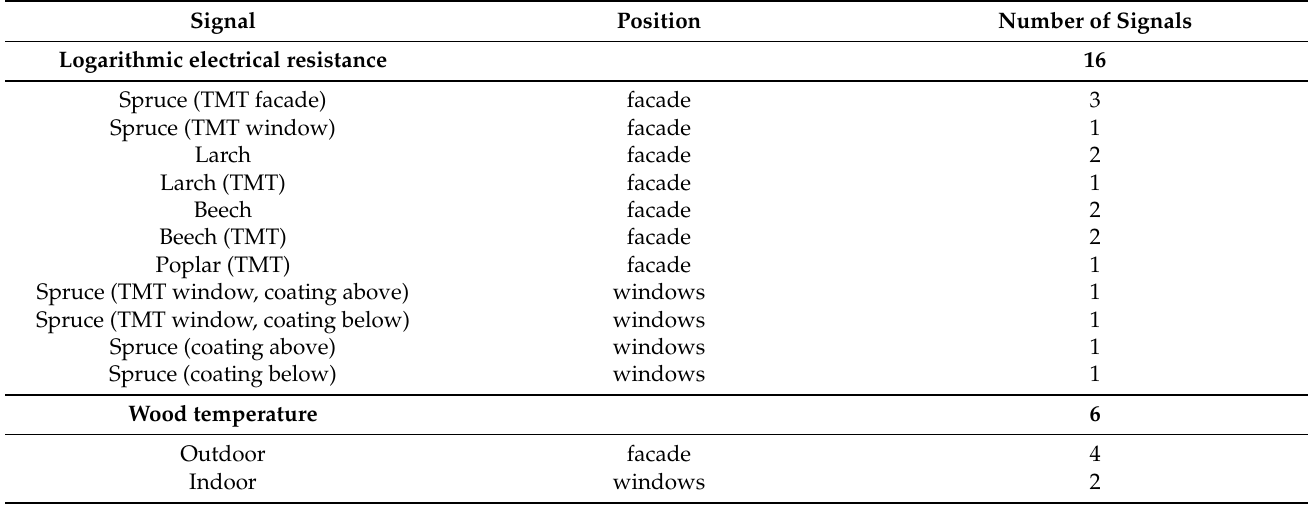
Table 1. Summary of the data used in this study. TMT stands for Thermally Modified Timber. For spruce, two different intensities were used, with a higher one used for the facade (TMT facade) and a lower one for the windows (TMT window). Note that a spruce sample to which the “TMT window” modification was applied was installed in the facade for comparison purposes. A thin acrylic coating was applied to the spruce samples installed in the